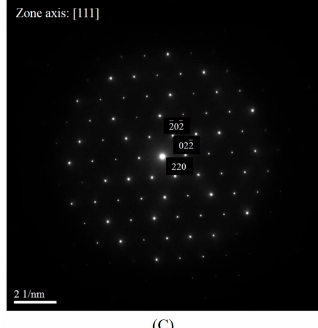
Figure 8. ( A ) Morphology of resolidified liquid phases; ( B ) composition of phases analyzed by EDS; and ( C ) diffraction pattern of phase d .